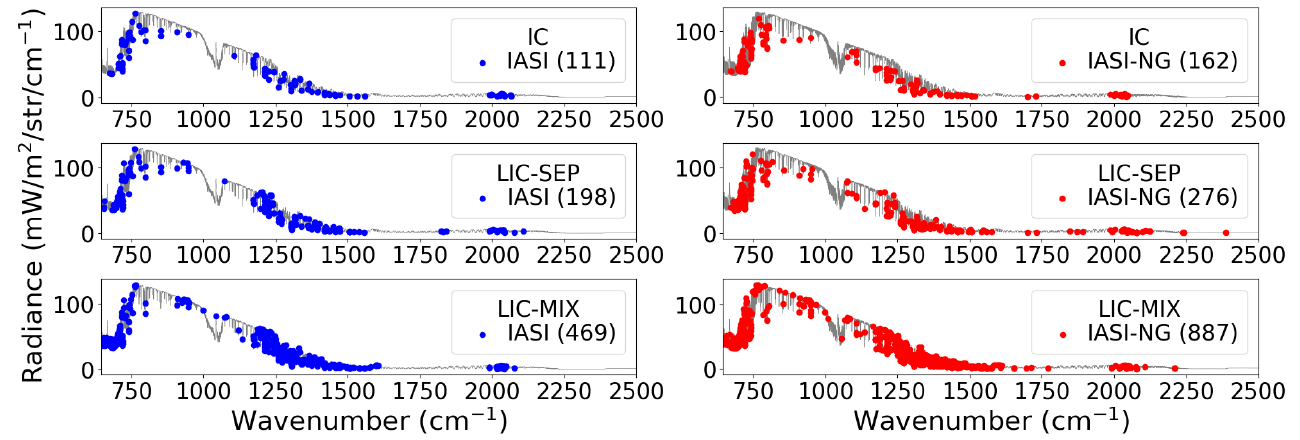
Figure 5. Selected channels for ice cloud properties retrievals for IASI ( left , blue) and IASI-NG ( right , red) for IC ( upper ), LIC-SEP ( center ), and LIC-MIX ( lower ) with the indicated number of channels. The gray curves represent typical IASI and IASI-NG spectra computed under clear-sky